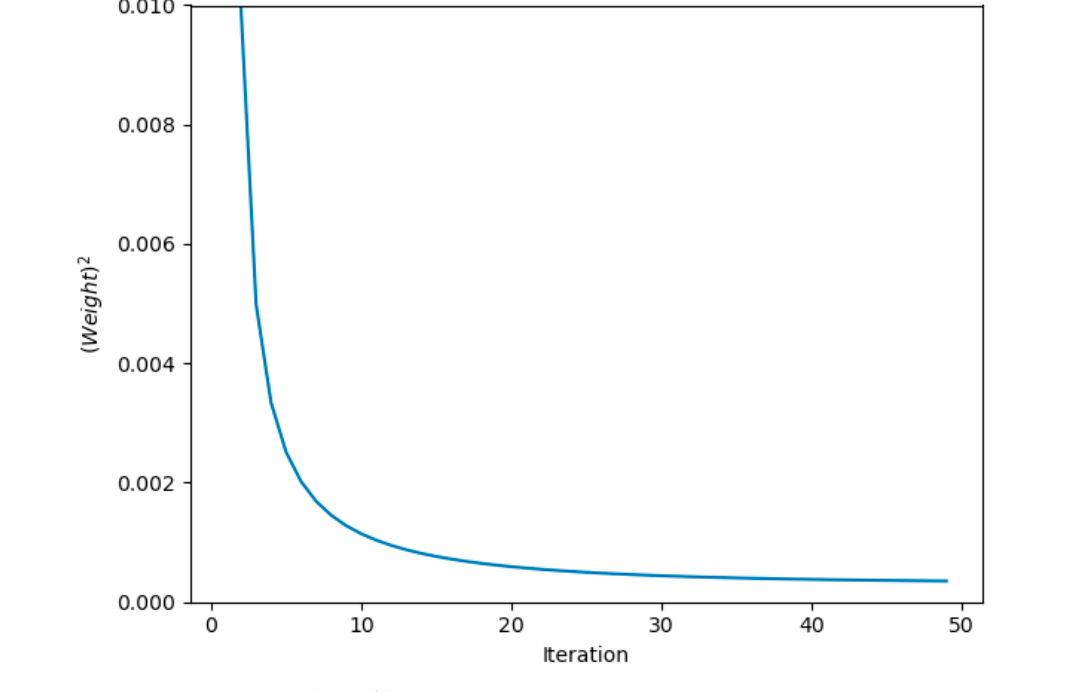
Figure 4. Variation in Kalman filter precision.